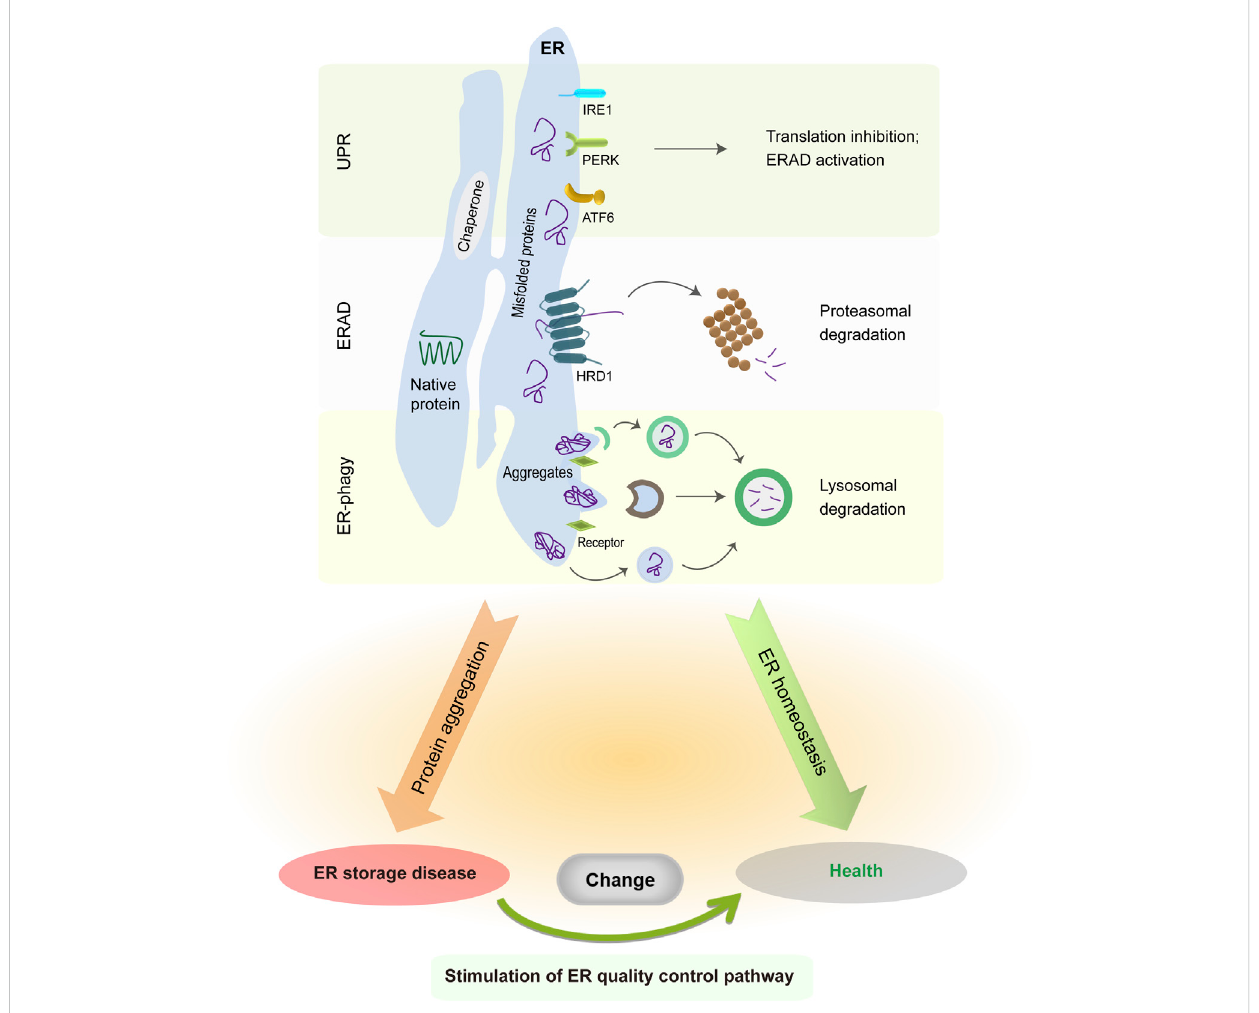
FIGURE 1 ER protein quality control system in normal and pathological conditions. The UPR is initiated by three distinct sensors, whose activation suppresses globalproteintranslationbutenhancesERfoldinganddegradationcapabilities.ER-residentfaultyproteinscanbetransportedtothecytosolviatheERAD complex and are degraded in the cytoplasmic proteasome. Meanwhile, insoluble protein aggregates are recruited to the ER-phagy receptors and then delivered into the lysosomes for degradation. The accumulation of misfolded protein aggregates in the ER causes illness, whereas enhancing ERAD or ER-phagy activity is suf fi cient to alleviate disease